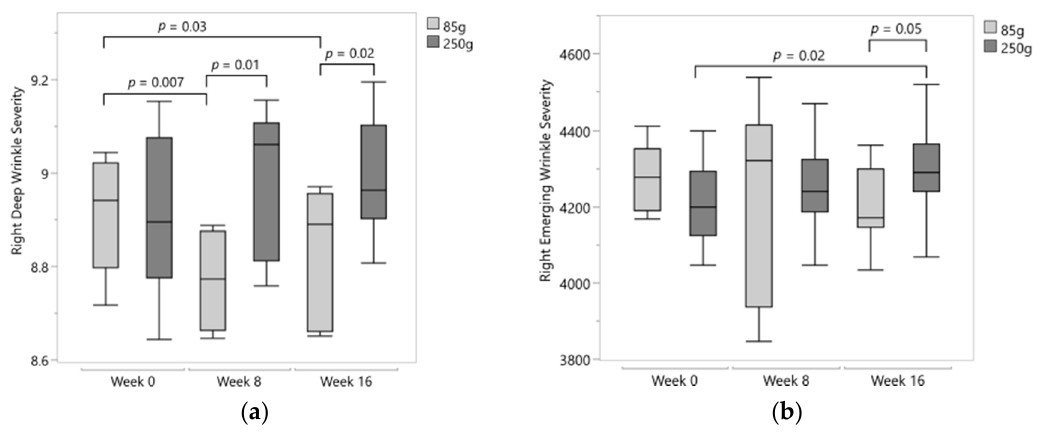
Figure 3. ( a ) Right deep wrinkle severity was significantly different between groups at week 8 ( p = 0.01) and 16 ( p = 0.02) and significantly decreased by week 8 ( p = 0.007) and 16 ( p = 0.03) in the 85 g group. Data transformed by natural log. ( b ) Right emerging wrinkle severity significantly increased ( p =